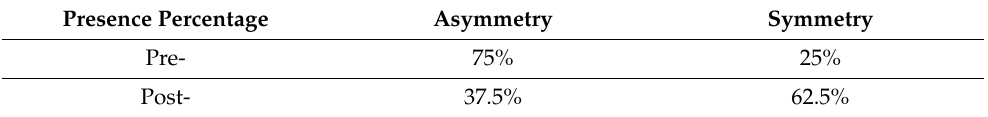
Table 2. Percentage symmetry of opening and closing mouth.